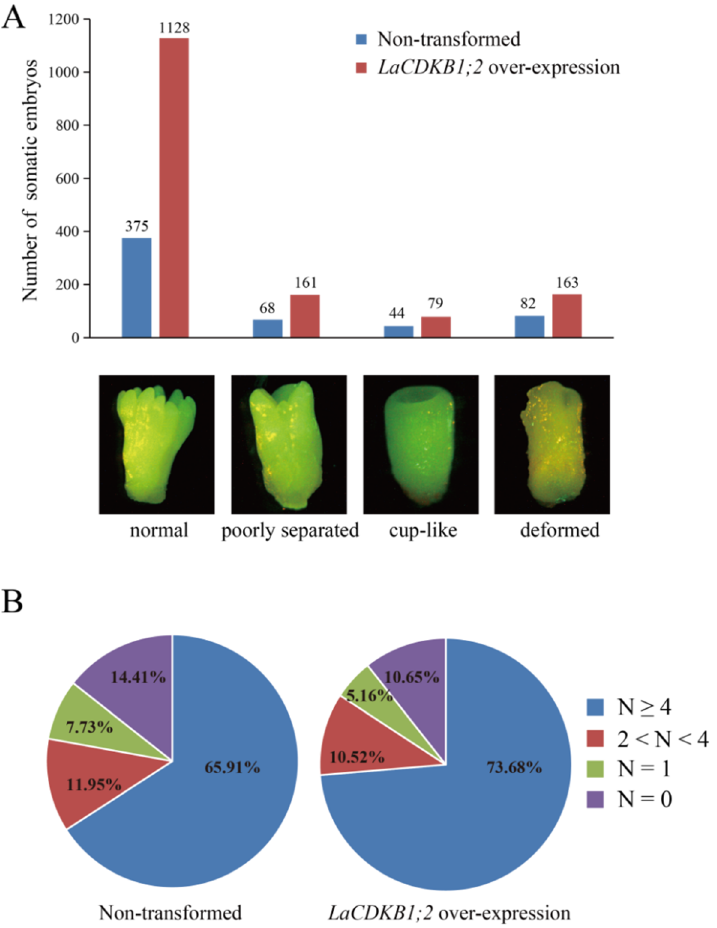
Figure 9. The statistical analysis of somatic embryos derived from L. kaempferi transgenic ( LaCDKB1;2 over-expression) cultures. ( A ) The numbers and photographs of four types of somatic embryo. ( B ) Statistical analysis of four types of somatic embryo. Non-transformed and LaCDKB1;2 over-expression S287 cultures of the same weight (0.5 g) were cultured on a solid maturation medium for 42 days in a plate and then used to analyze the morphology and number of somatic embryos. Data are presented as the total numbers of the four types of somatic embryo generated from 10 plates of culture. N: number of cotyledons.